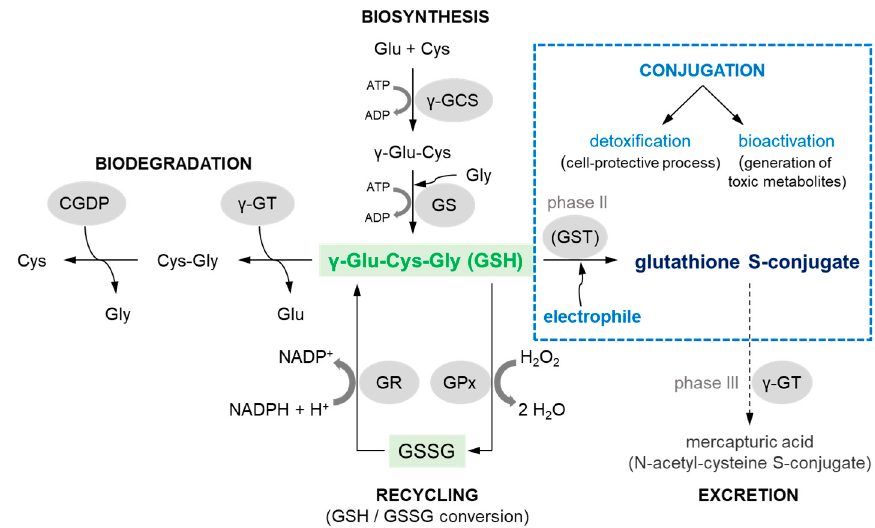
Figure 2. Comprehensive scheme of biosynthesis, biodegradation, and the most important reactions that reduced glutathione (GSH) may undergo in mammalian cells (scheme based on [47]). ADP = adenosine 5 ′ -(trihydrogen diphosphate); ATP = adenosine 5 ′ -(tetrahydrogen triphosphate); CGDP = cysteinylglycine dipeptidase; Cys = cysteine; Cys-Gly = cysteinylglycine; Glu = glutamic acid; Gly = glycine; GPx = GSH peroxidase; GR = GSH reductase; GS = GSH synthetase; GSSG = glutathione (oxidized form); GST = GSH S-transferase; H + = positively charged hydrogen ion; H 2 O = water; H 2 O 2 = hydrogen peroxide; NADPH/NADP + = β -nicotinamide adenine dinucleotide 2 ′ -phosphate, reduced/oxidized form, respectively; γ -GCS = γ -glutamylcysteine synthetase; γ -Glu-Cys = γ -glutamylcysteine; γ -GT = γ -glutamyl transferase.